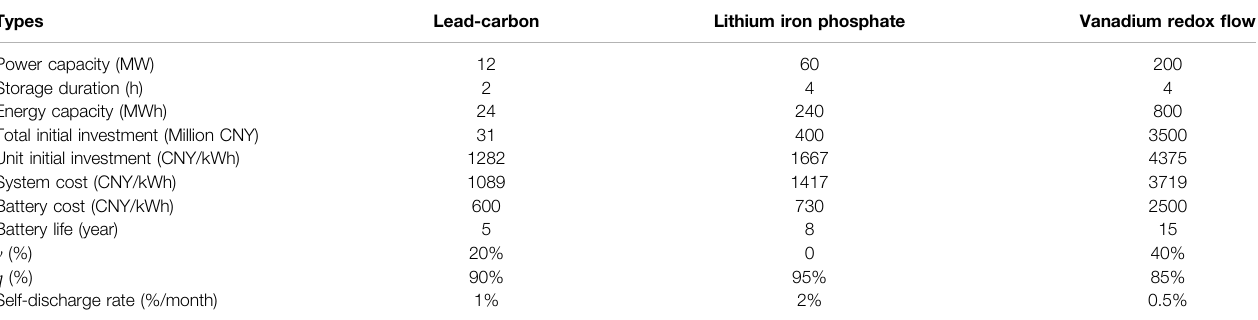
TABLE 4 | Speci fi c parameters for the three different types of EES projects.